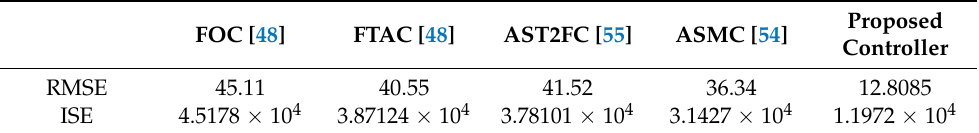
Table 4. Comparison of the RMSE for different values of the fractional orders. q 0.5